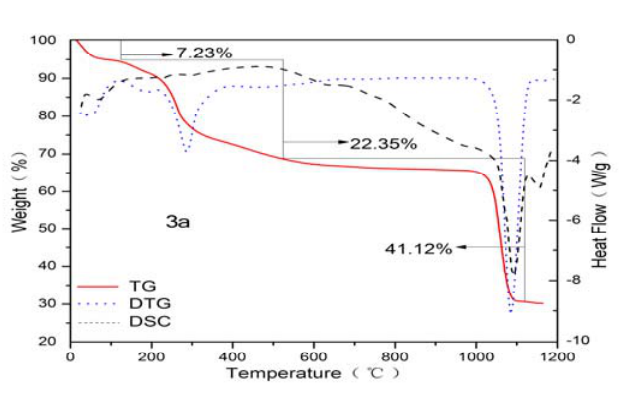
Figure 4. The thermal gravimetric curves of 3a.